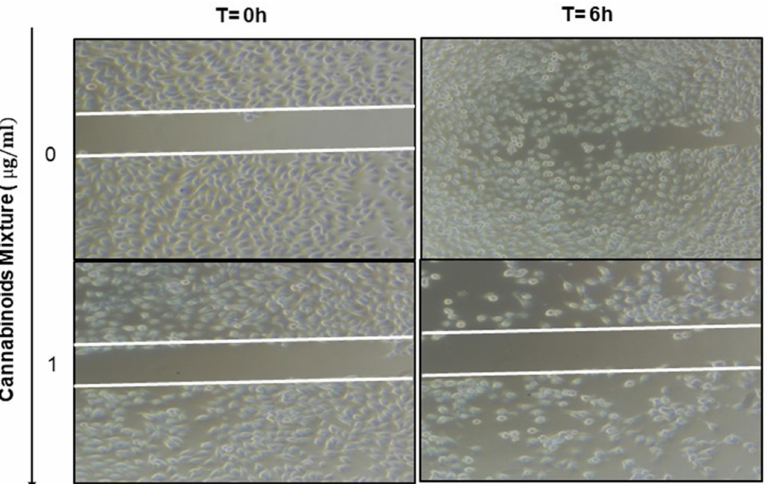
Figure 7. Wound-healing assay and transcription factor expression. The effect of CM on cell migration was determined by the scratch method. Unstimulated Ca9-22 cells were compared to CM-treated Ca9-22 cells. The cell migration was analyzed by image-processing software that was able to measure the distance between opposite edges of the scratch at each time point. All wells were then compared, based on their percentage of